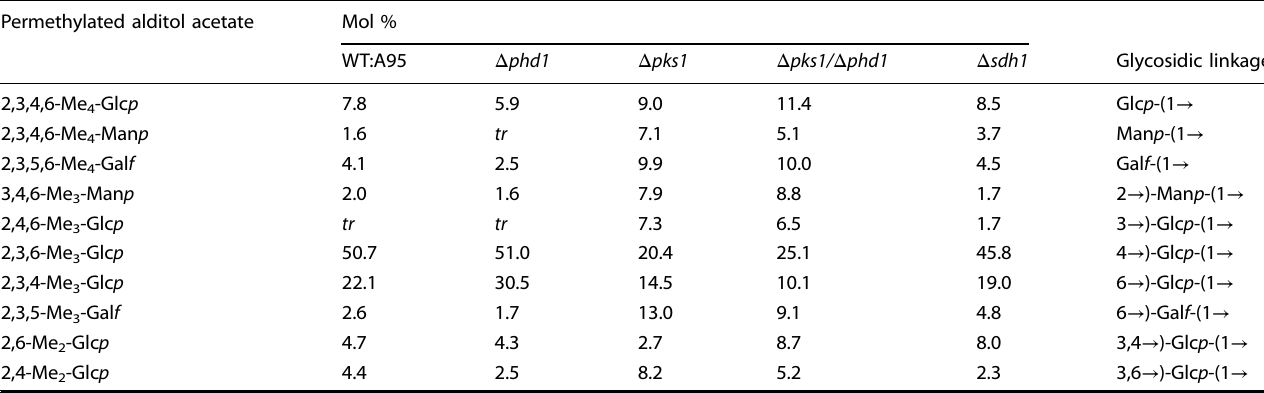
Man, mannose; Glc, Glucose, Gal, Galactose; f , furanose form; p , pyranose form; tr, traces. The WT data have already been published 15 and are shown again for comparison. The mean values of three biological replicates are listed. The uncertainty representing twice the standard error of the biological replicates is